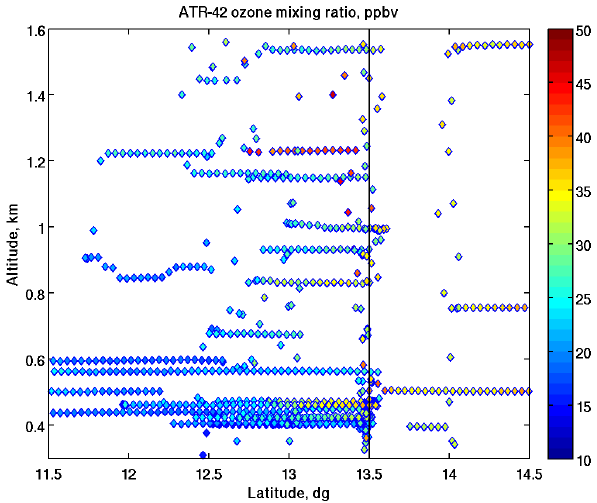
Fig. 5. Meridional O 3 mixing ratio vertical cross section derived from the ATR-42 flights in August 2006 near Niamey, the position of which is marked by the black line.